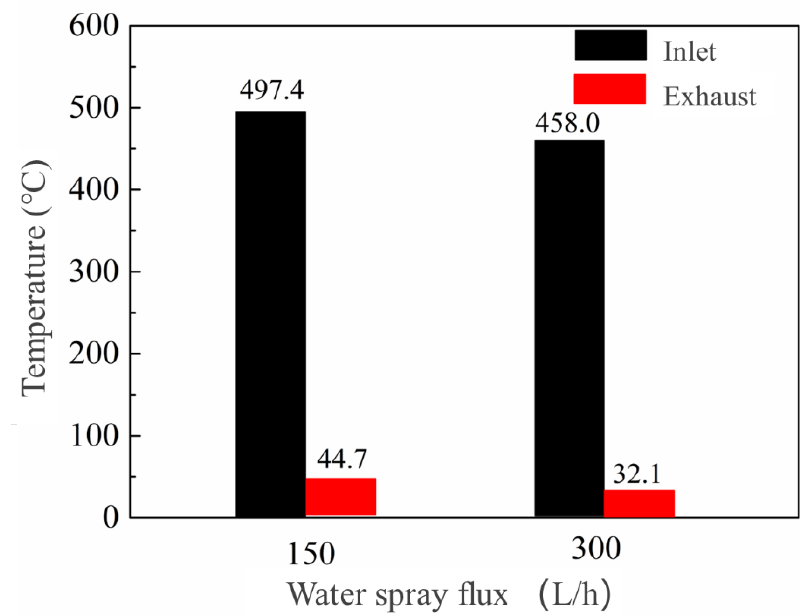
Figure 18. Inlet/exhaust temperature of FSDS.